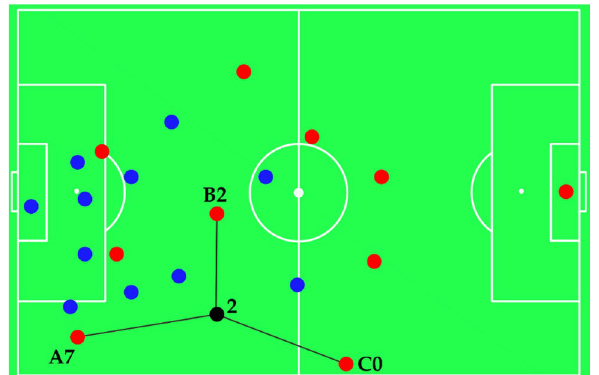
Figure 1. Blue dots correspond to the defensive team players, while the red dots represent the attacking team players. The black dot corresponds to the ball carrier. The numbers near each red dot (i.e., attacking player) corresponds to his/her outplay opponents. Letter A corresponds to a penetrative pass, as the attacking player (and potential receiver) outplays more opponents than the current ball carrier. Letter B corresponds to a support pass as the attacking player (and potential receiver) outplays the same number of opponents as the current ball carrier. Letter C corresponds to a backward pass as the attacking player (and potential receiver) outplays less opponents than the current ball